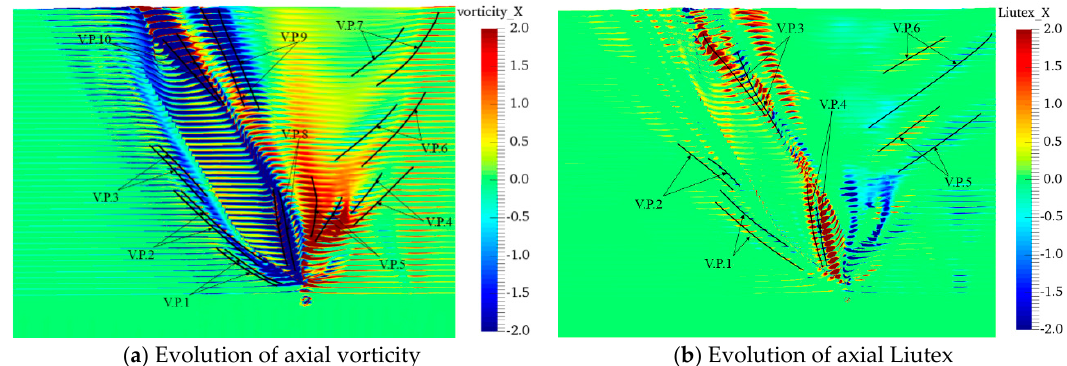
Figure 9. Evolution of the axial vorticity ( a ) and Liutex ( b ) along the ship length direction in CASE DA20.